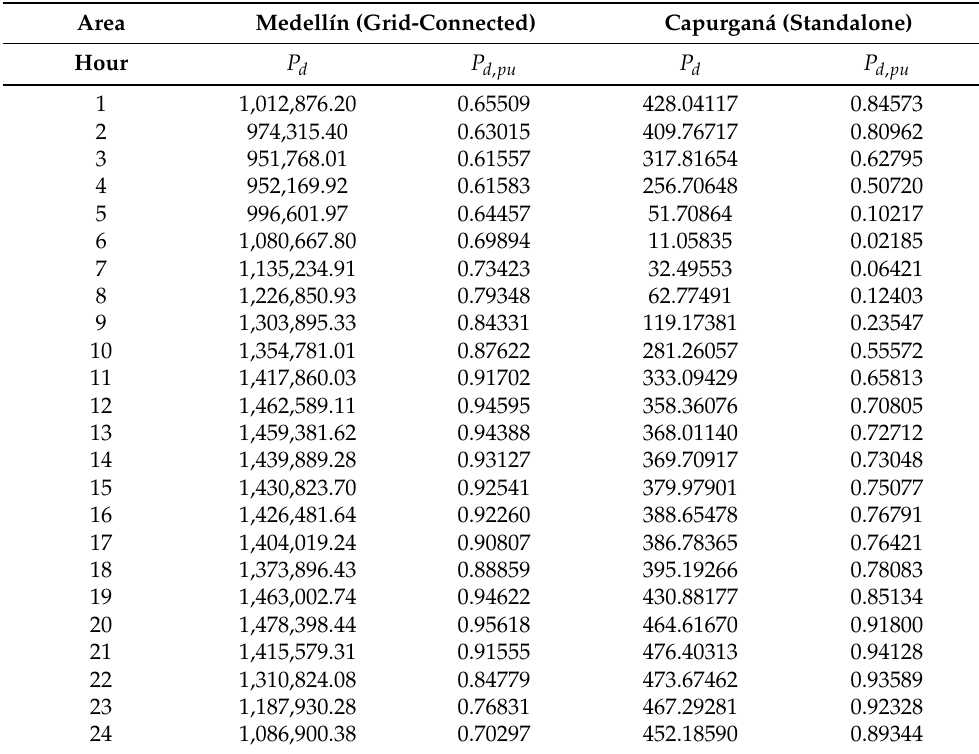
Table 6. Power consumption data (kW) and behavior (p.u.) for an average day in the areas un- der study.